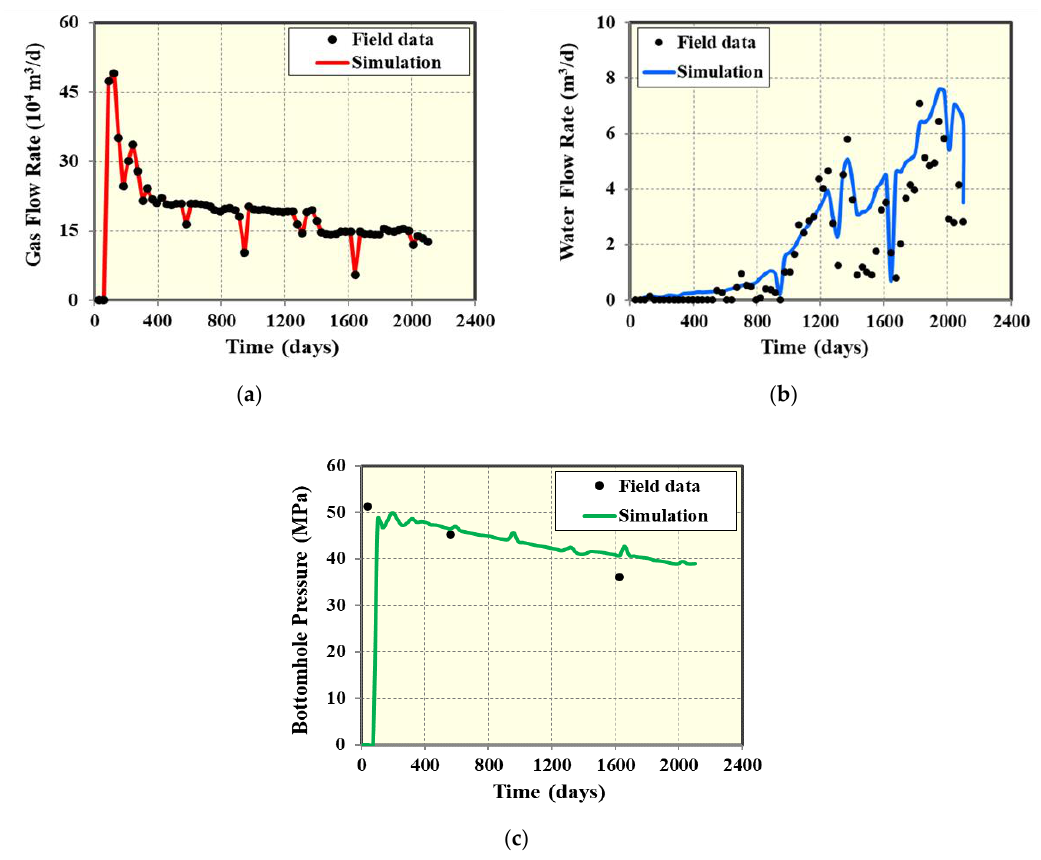
Figure 29. Single-well model simulation and history matching results of well B2. The points represent the field data while the solid lines represent the simulated values: ( a ) gas flow rate history matching results; ( b ) water flow rate history matching results; ( c ) BHP history matching results.